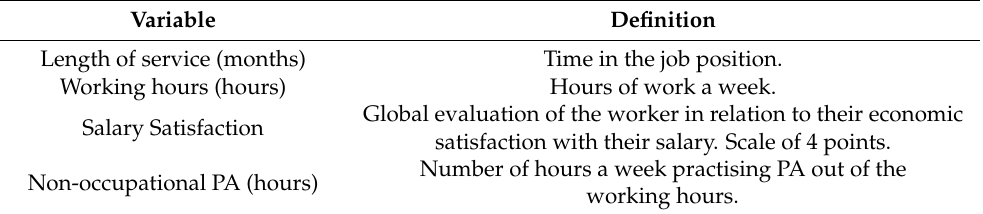
Table 2. First part of the questionnaire: dichotomous and categorical